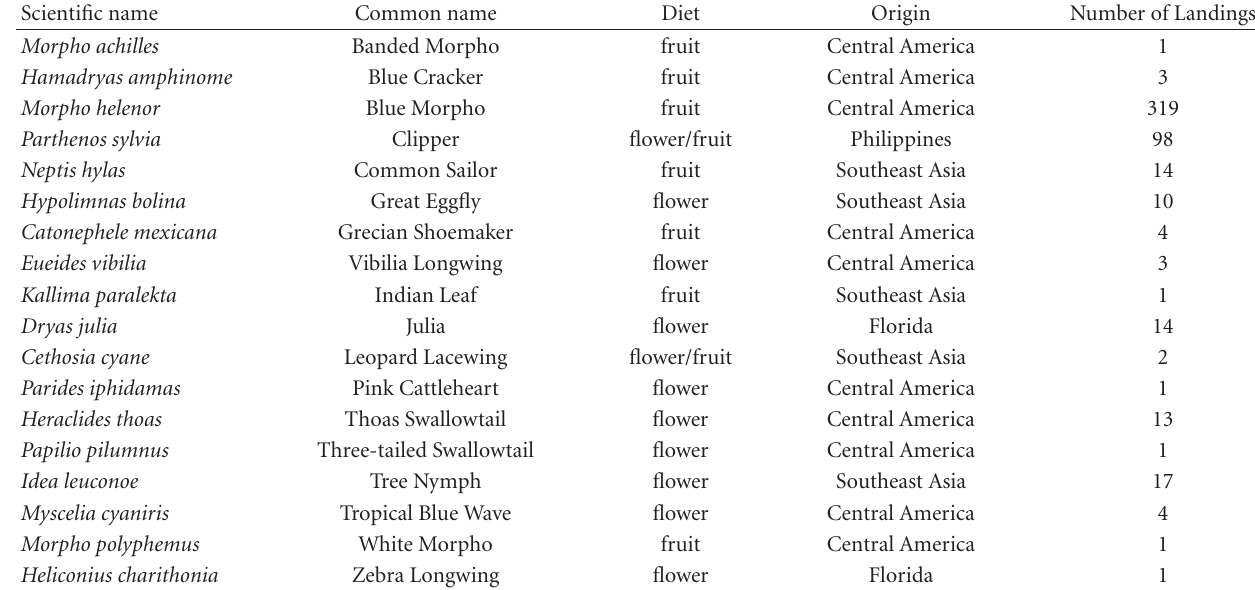
Table 1: Butterfly species that visited landing platforms during Bioassay